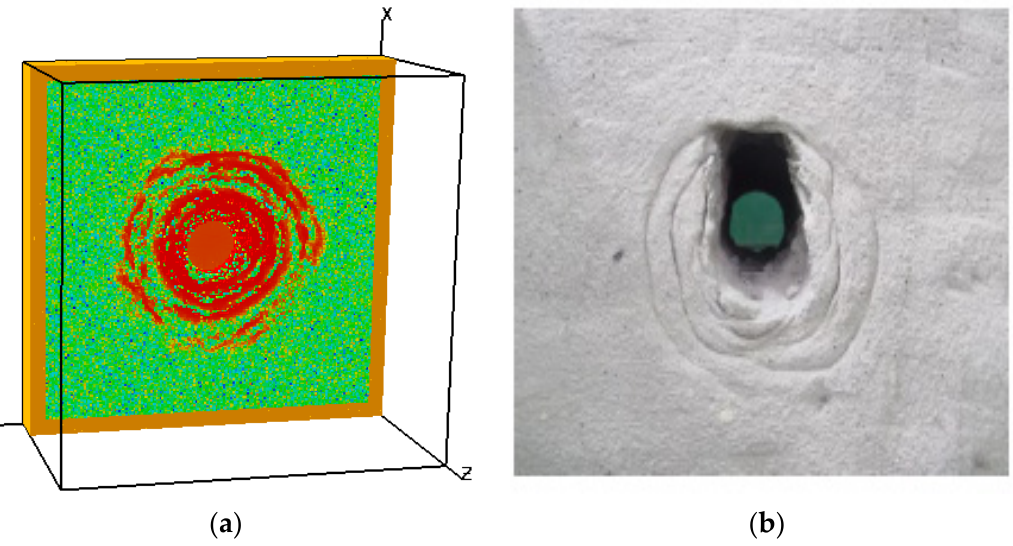
Figure 4. Comparison of model fracture patterns: ( a ) Numerical simulation result; ( b ) laboratory model test result (Gao et al. [37]).